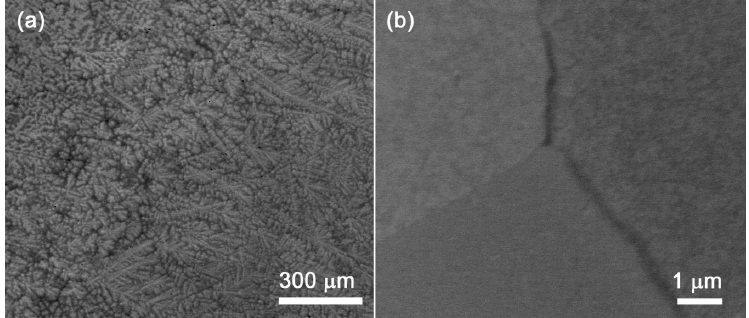
Figure 16. SEM micrograph (back-scattered electrons) of HfNbTaTiVZr alloy in the as-cast state: ( a ) an overview of the microstructure, ( b ) a detail of the grain boundary enriched in V.